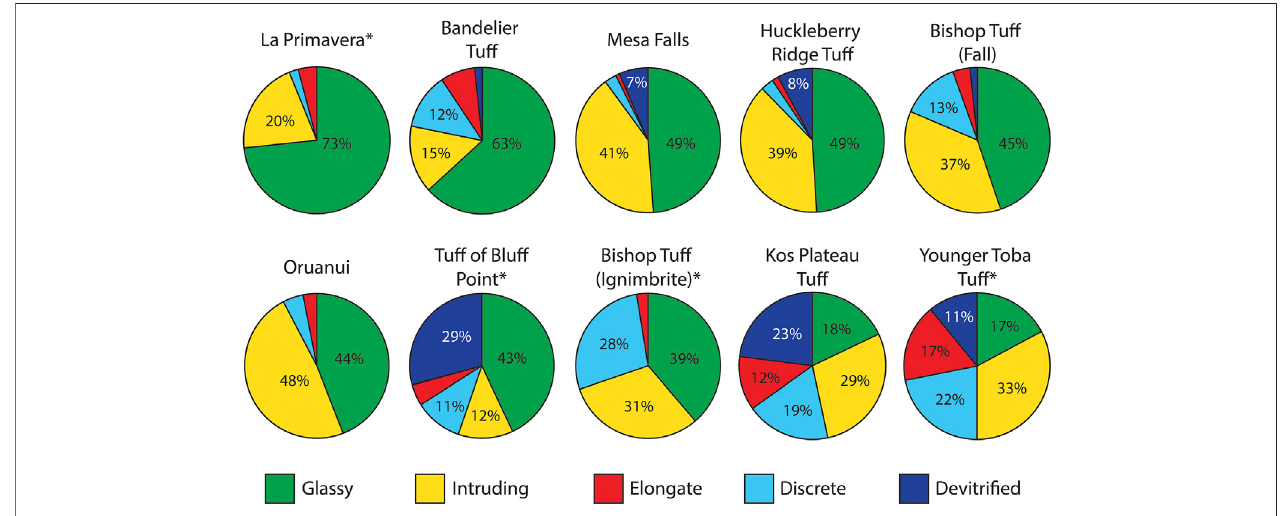
FIGURE 8 | Relative abundance of bubble textures within embayments. Samples from ignimbrites indicated with an asterisk.